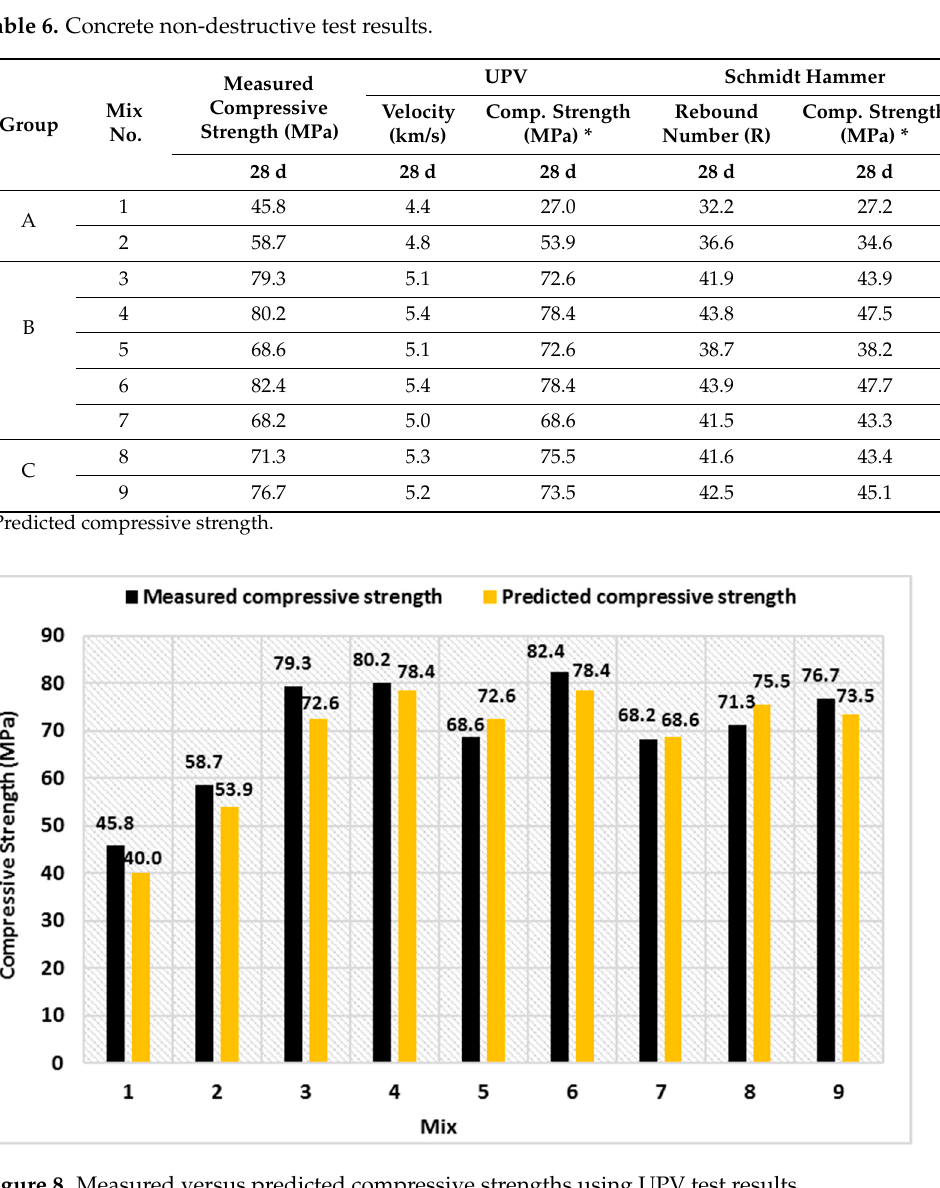
Figure 9. Measured versus predicted compressive strengths using Schmidt hammer test results. 3.6. Microstructural Analyses SEM and EDX analyses were carried out on concrete samples taken from tested spec- imens of mixes 1, 2, and 6. Figure 10 shows the SEM images taken for the three mixes. As